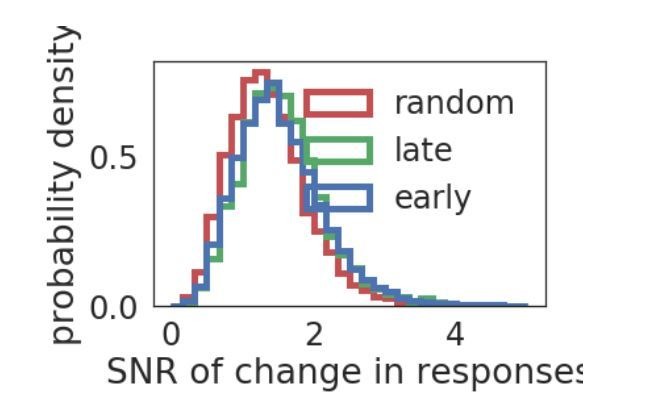
Distribution of SNR.